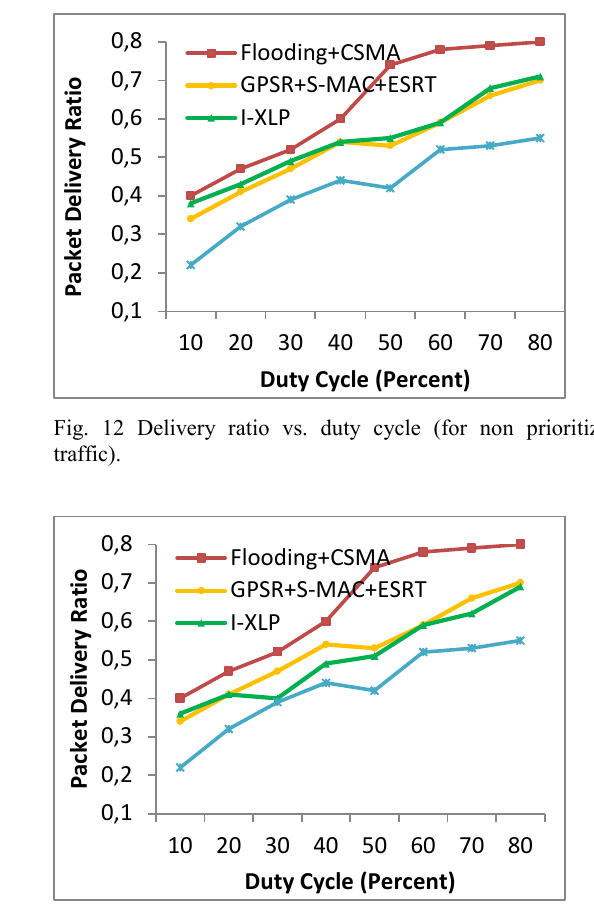
Fig. 13 Average delivery ratio vs. duty cycle (For prioritized